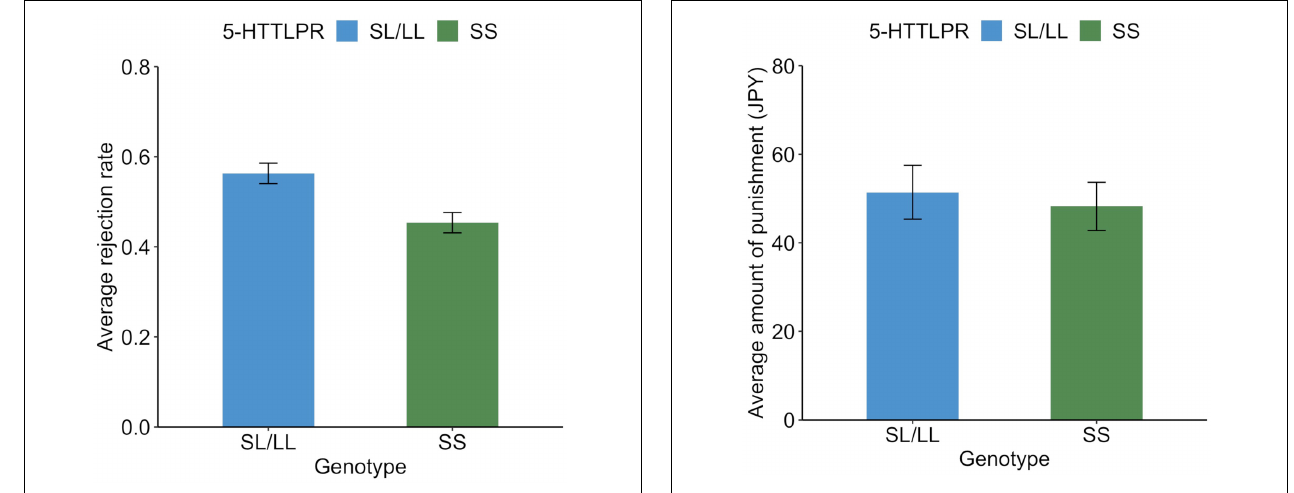
FIGURE 3 | Behavioral response to unfair distribution in the third-party punishment game among each genotype. Average amount of punishment for